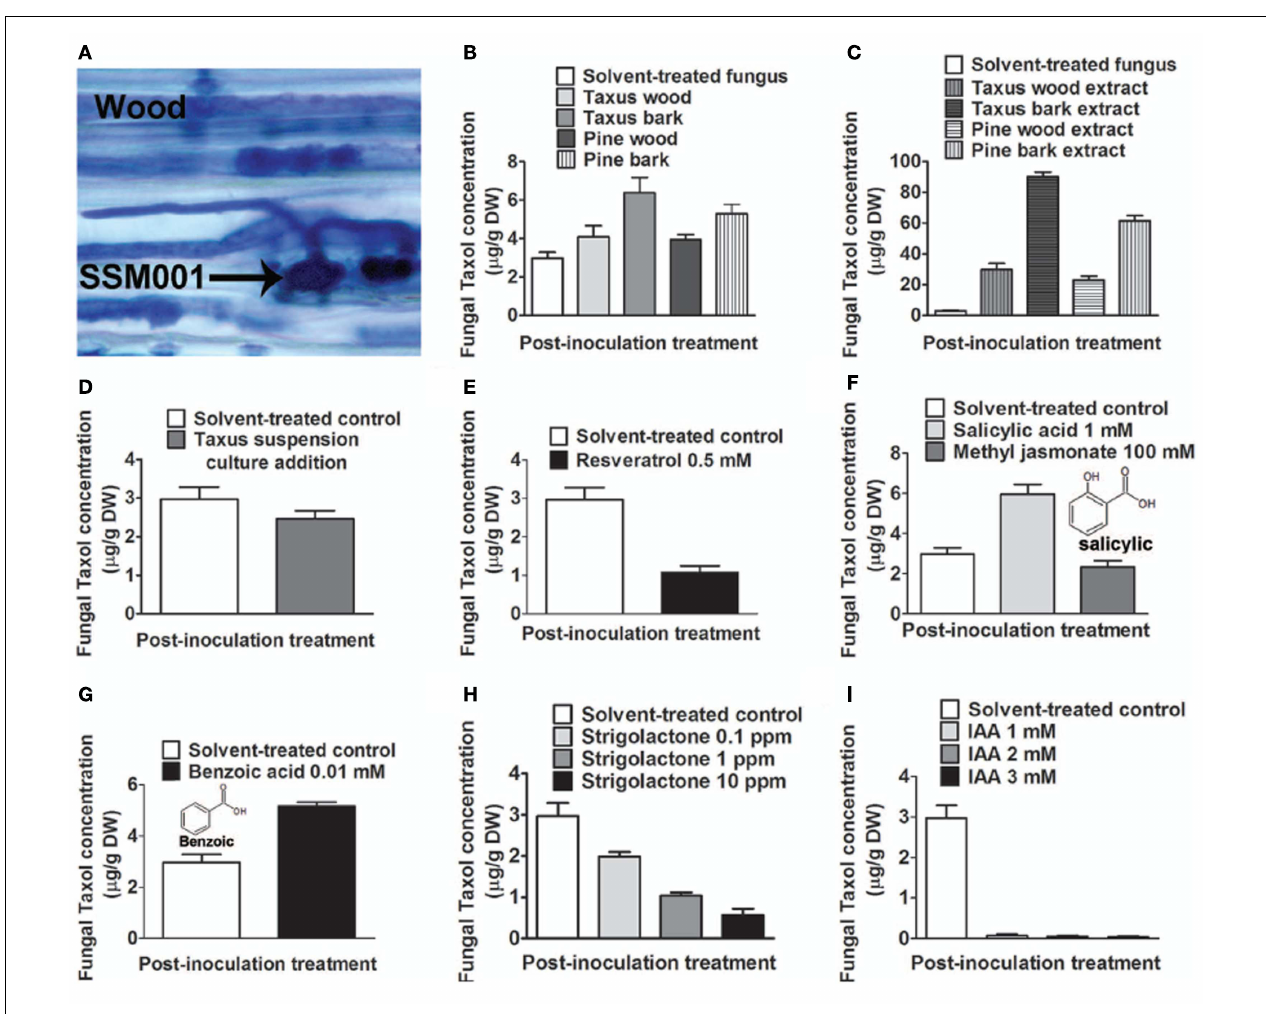
suspension culture cells to test whether Taxus contributes precursors for fungalTaxol biosynthesis. (E) Effect of the antimicrobial phytoalexin, resveratrol. (F) Effect of plant defense hormones. (G) Effect of benzoic acid, a derivative related to salicylic acid. (H) Effect of strigolactone, a plant hormone that stimulates fungal germination and penetration, and which is localized to vascular cells. (I) Effect of indole acetic acid (IAA), a plant growth hormone important in vascular tissue